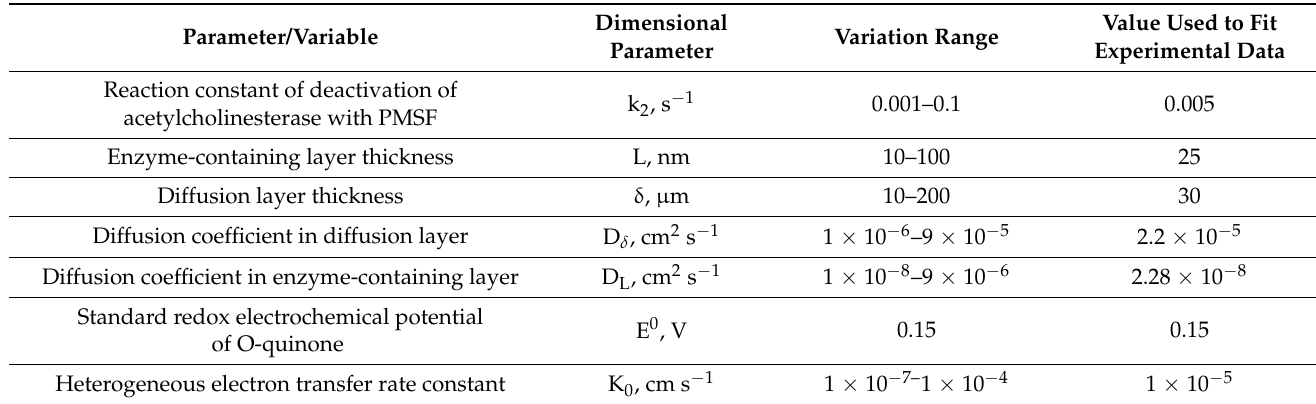
Figure 7. Control experiment to study the effect of phosphate buffer addition on the bi-enzyme bi- osensor’s signal. The PMSF-challenge experiments described above were repeated for samples con- taining a variety of PMSF concentrations. Figure 8 shows the current to which the signal returned after the initial decline as a function of the PMSF concentration in the sample.